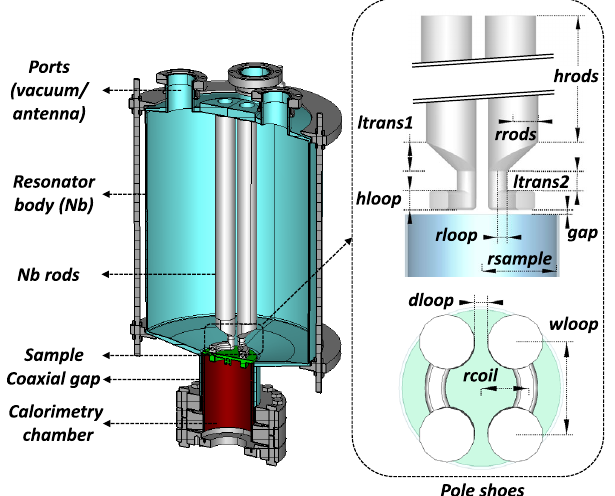
FIG. 3. Cross section of a HZB-QPR (left) and a parameterized model of the pole shoes (right). The nomenclature used in the parameterization of the pole shoes follows